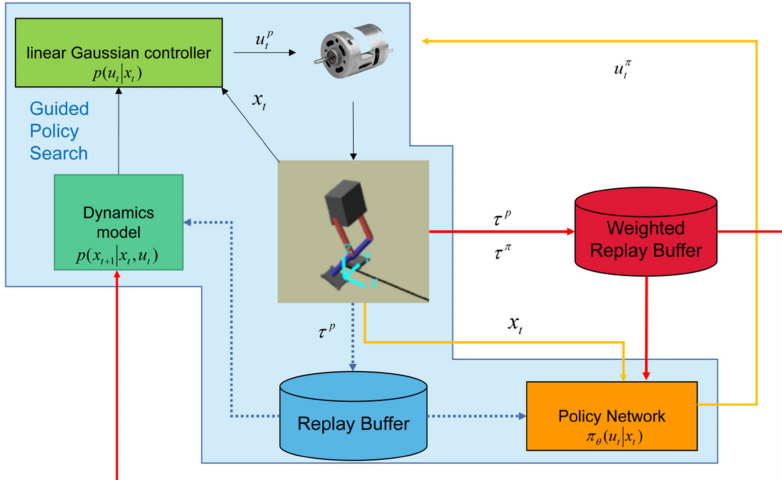
Figure 1. Schematic diagram of weighted near-optimal experiences policy optimization (WNEPO). Blocks in the blue background are about guided policy search (GPS). WNEPO replaces the replay buffer in GPS with the weighted replay buffer to select the experiences with high quality. When the performance of the policy network is close to that of the linear Gaussian controller, the policy network directly interacts with the environment. In WNEPO, the blue dotted line in the above figure is not executed.